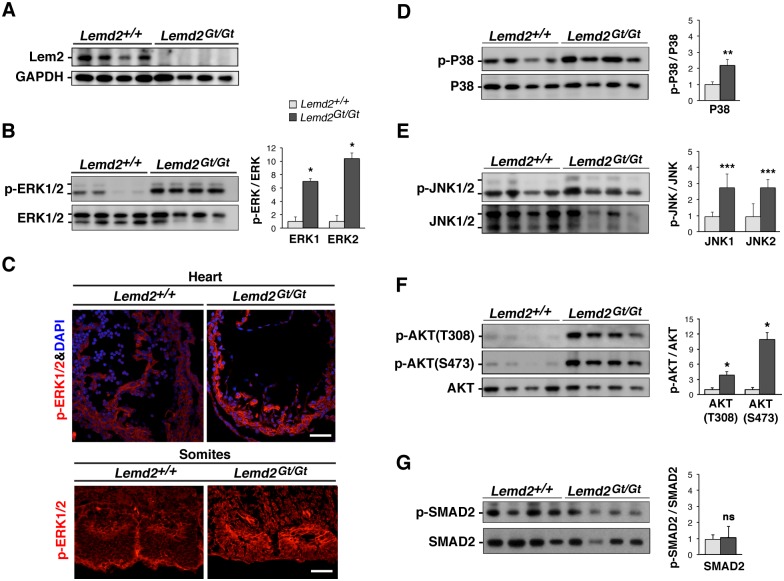
Activation of MAP kinase and AKT signaling pathways in Lemd2-deficent embryos.(A, B, D-G) Western blot analysis of protein extracts from Lemd2
+/+ and Lemd2
Gt/Gt embryos at E10.5. Samples from 4 separate embryos of each genotype are shown. All extracts were from embryos with beating hearts. (A) Labeling with anti-Lem2 and anti-GAPDH. (B, D-G) Labeling with antibodies to the phosphorylated activation sites of various kinases or kinase effectors (upper panels) and to nonphosphorylated epitopes of the corresponding proteins (lower panels). (B) Anti-ERK1/2. (D) Anti-p38. (E) Anti-JNK1/2. (F) Anti-AKT. (G) Anti-Smad2. Error bars indicate standard deviations (*p < 0.0005, **p < 0.005, ***p < 0.05, ns “not significant”). (C) Immunofluorescence staining of sagittal cryosections of Lemd2
+/+ and Lemd2
Gt/Gt hearts and somites at E10.5 with anti-phospho-ERK1/2 antibodies. All images were captured and displayed with exactly the same parameters.